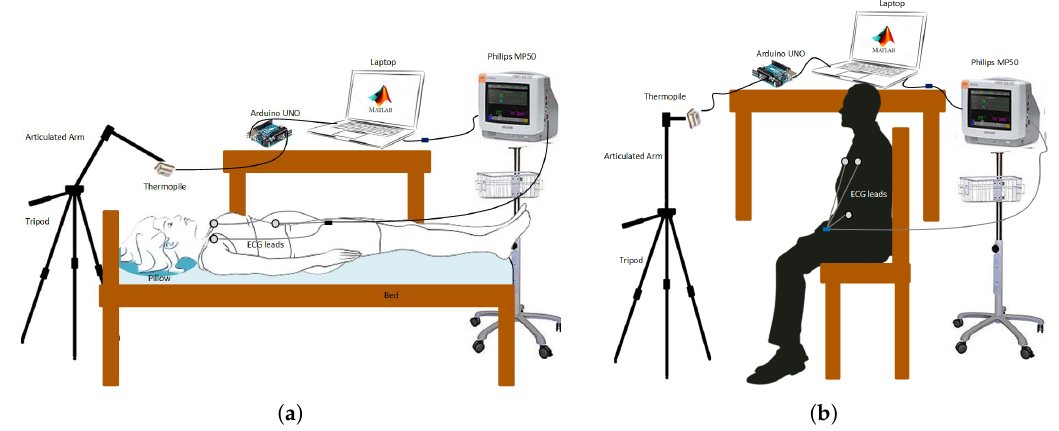
Figure 3. Experimental setup: ( a ) subject lying down on a bed; ( b ) subject in a seated